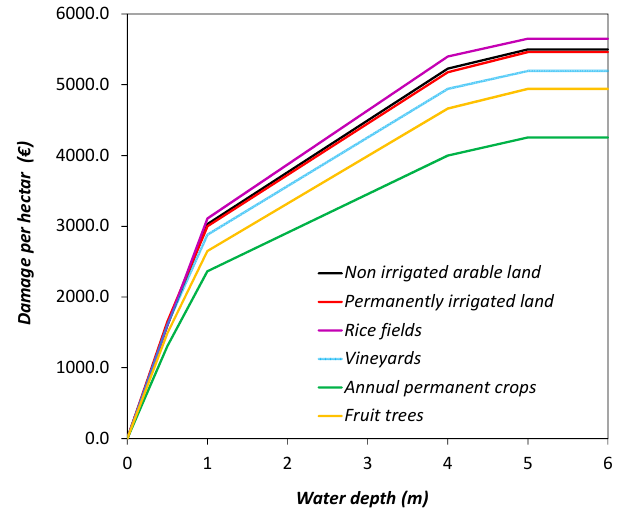
Figure 5. Damage related to water depth for agricultural areas.